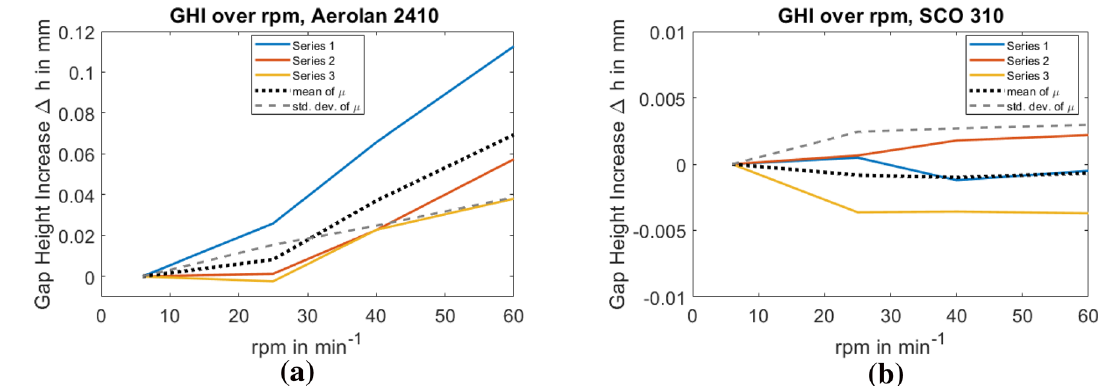
Fig. 6 Measured gap height increase over rotational speed when fully filled: a Aerolan 2410 emulsion with 90% H